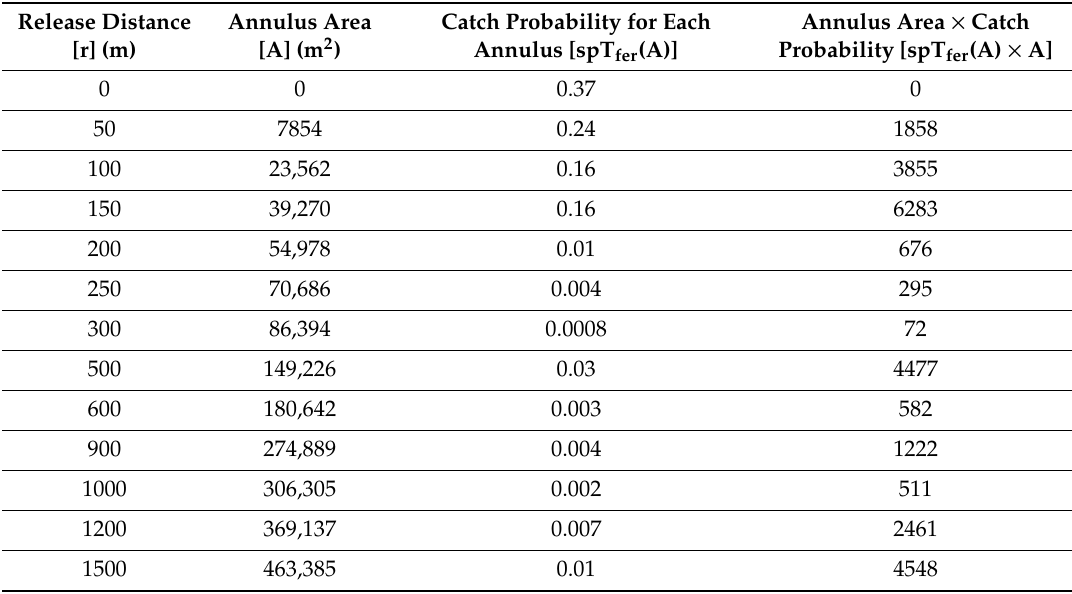
Table 2. Catch probability at various distances from male gypsy moth release point. Catch probability is calculated based on the data reported here using existing methods